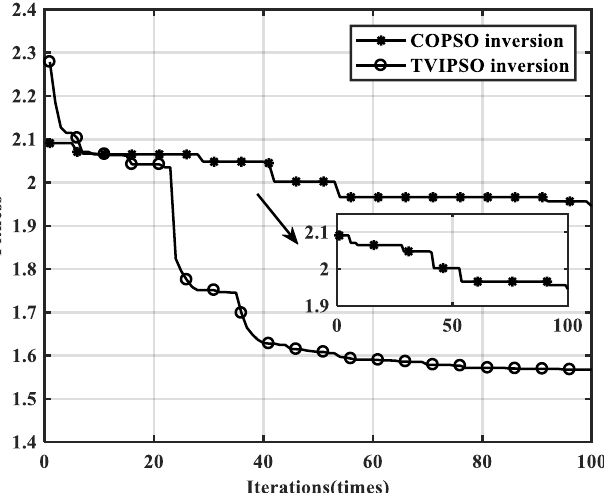
Figure 21. Convergence curves of fitness functions for COPSO inversion and TVIPSO inversion algorithms.